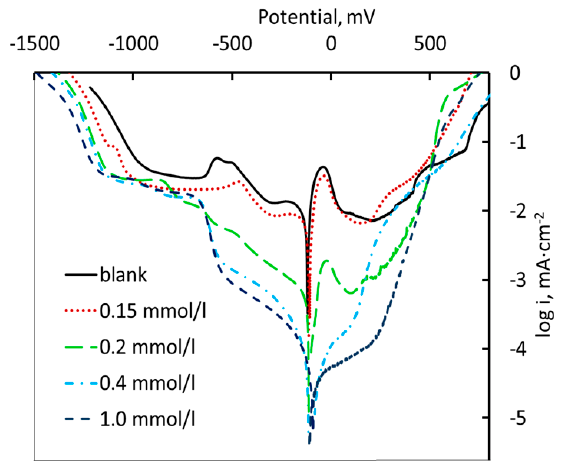
Figure 2. The anodic and cathodic polarization curves of brass in borate buffer solution depending on MPATA concentration (0.01 M NaCl pH 7.4).